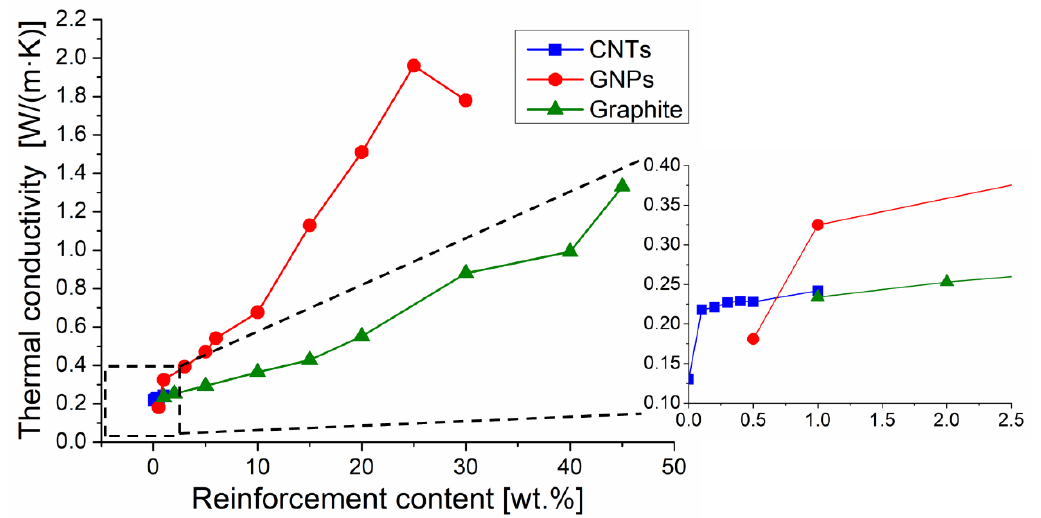
Figure 5. E ff ect of filler content on the thermal conductivity of Figure 5. Effect of filler content on the thermal conductivity of composites.